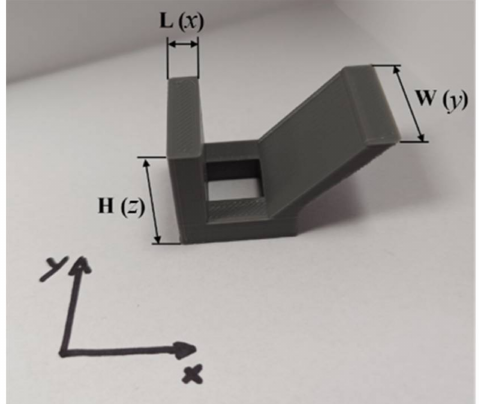
Figure 3. Reference geometry used to determine printer accuracy with dimensions L × H × W: 5 mm × 20 mm × 20 mm. The printing direction is in z .